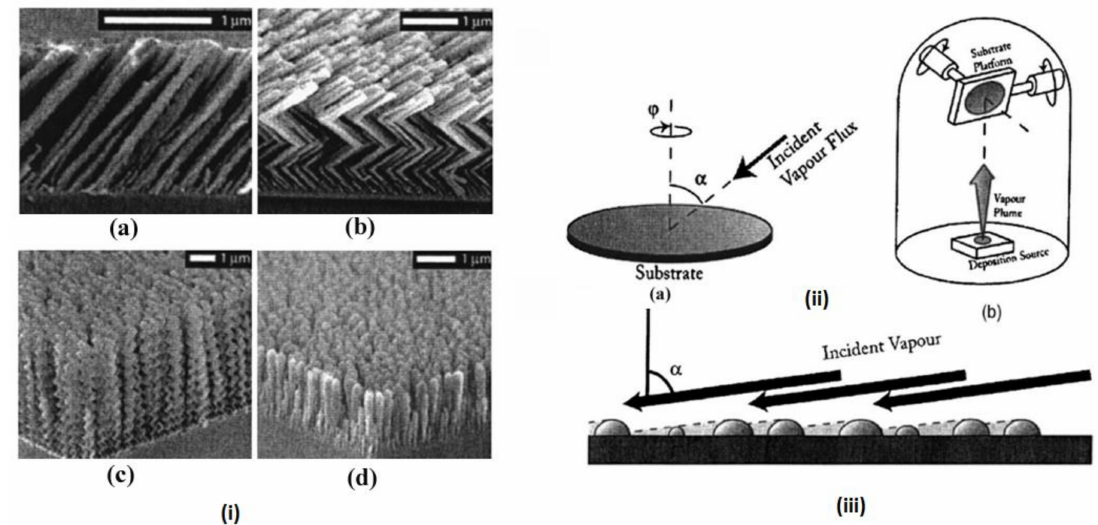
Figure 11. ( i ) GLAD deposited microstructures ( a ) tilted structures, ( b ) Chevron or zig-zag structures, ( c ) helical structures, ( d ) vertical columns. ( ii ) ( a ) The angle of deposition α and the rotation angle of the substrate Φ to the deposition plane. ( b ) Typical GLAD apparatus implemented in the PVD system. ( iii ) Nuclei distributed across the surface leads to ballistic shadowing of the surrounding regions. Reprinted with permission [79]; 2007, AIP